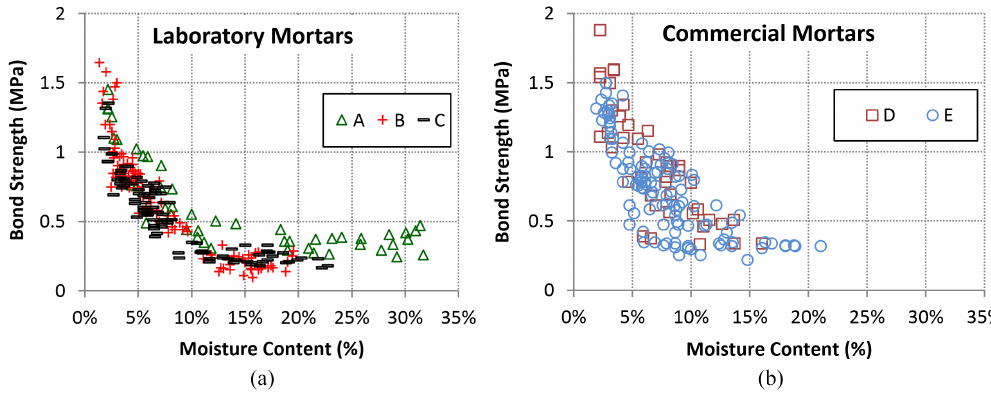
Figure 6. Influence of the moisture content on the bond strength during drying process for laboratory prepared mortars (a); and commercial mortars (b).